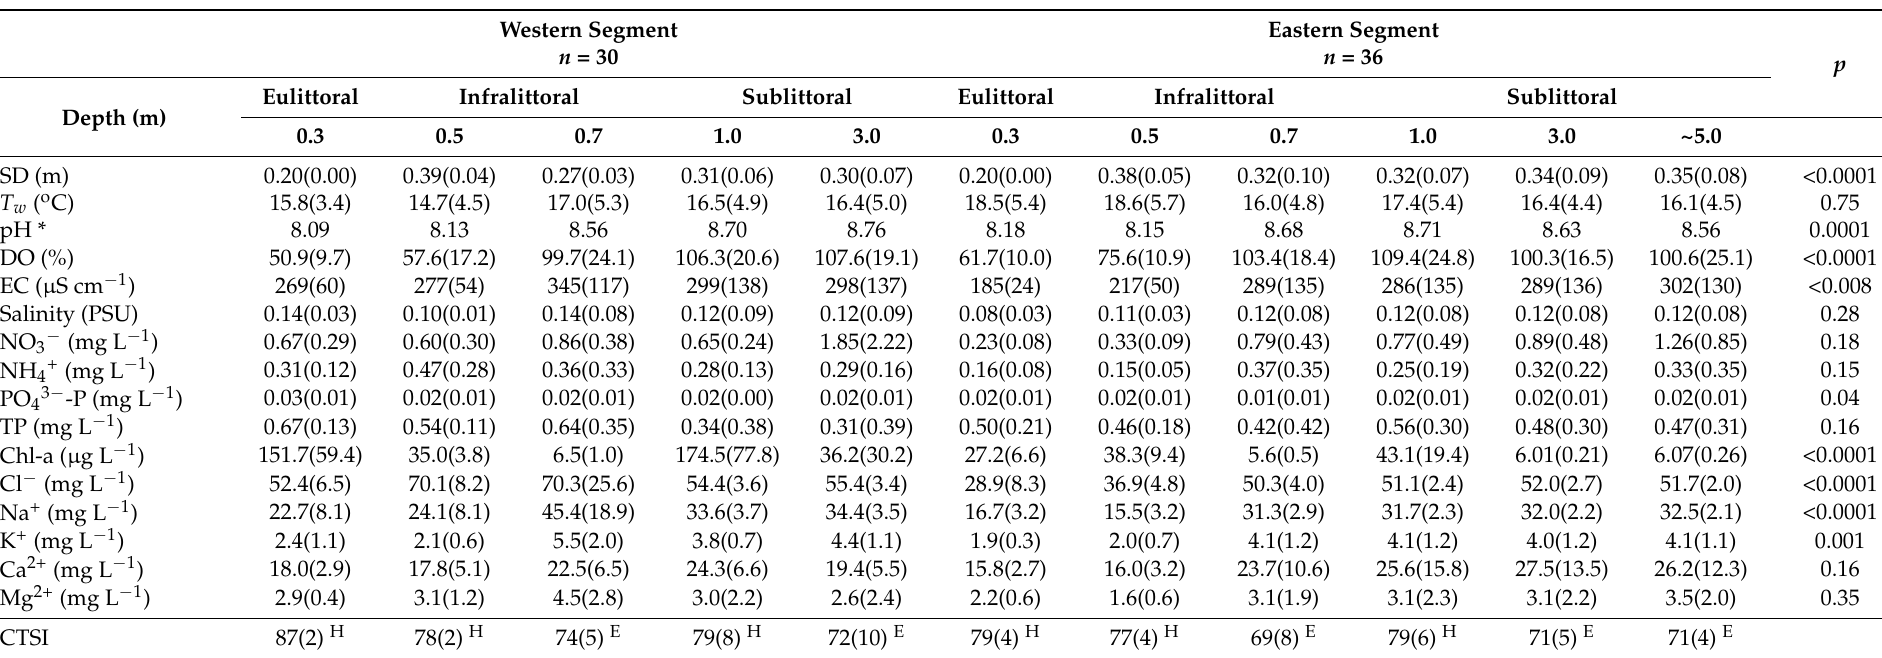
Table 1. Annual mean or median* ( ± Standard Deviation) of physicochemical parameters of water at different depths in two segments of Lake Wicko ( n = 66). Denotations: SD = Secchi depth; Tw = water temperature; EC = conductivity; DO = dissolved oxygen; TP = total phosphorus; CTSI = Carlson trophic state index; p = significance of differences between